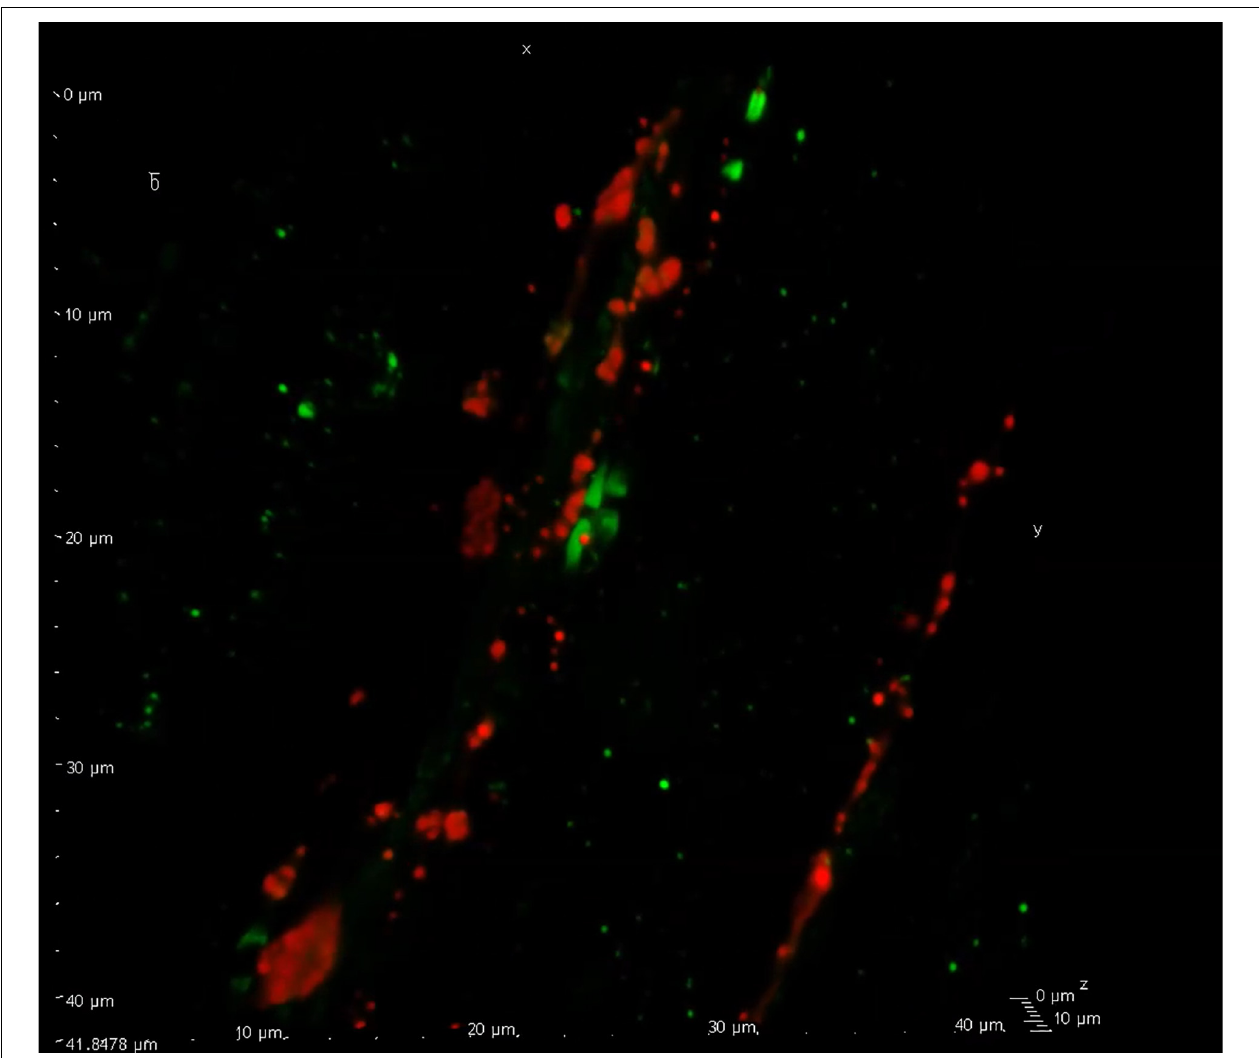
FIGURE 1 | Confocal visualization of the node of Ranvier. Confocal microscopy displaying calcitonin gene-related peptide (CGRP) (red) immunreactive C-fiber boutons flanked by two A δ -fibers with their paranodal regions marked with contactin associated protein 1 (CASPR, green). This close relationship between the two fiber types display a point of interaction for CGRP signaling within the trigeminovascular (TGV) system (see Supplementary Video ). For experimental details on antibodies etc., see Edvinsson et al.